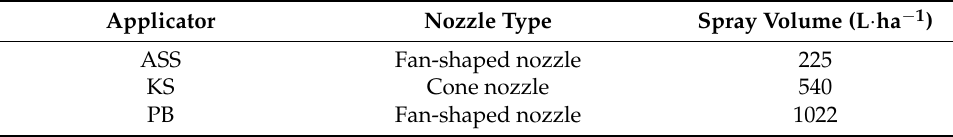
Figure 6. Two types of applicators for comparison: ( a ) knapsack sprayer; ( b ) spray gun. Table 2. The nozzle and spray volume of the ASS, KS and SG.